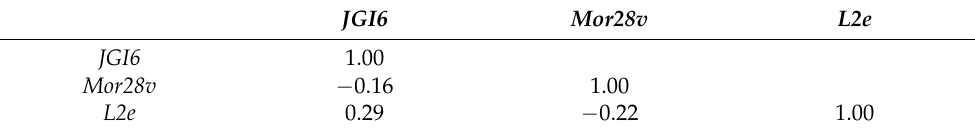
Table 5. Correlation matrix (correlation coefficient, R ) for the descriptors included in model (1).